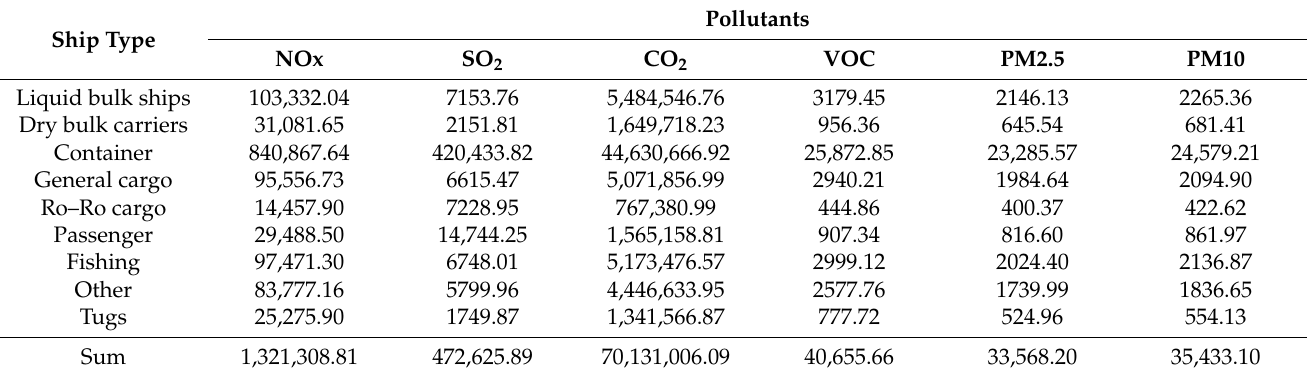
Table A1. Ship pollutant emissions by ship type at Busan Port in 2015 (ship activity phase: Hoteling) [kg].